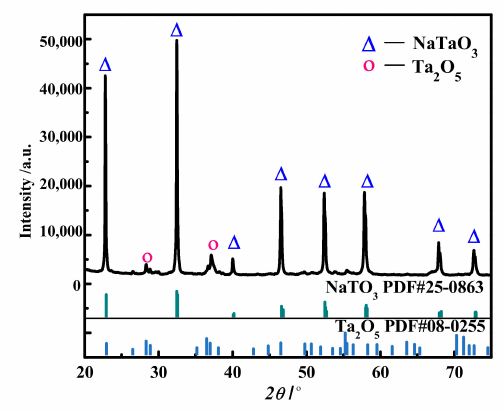
Figure 4. XRD diagram of the decomposed